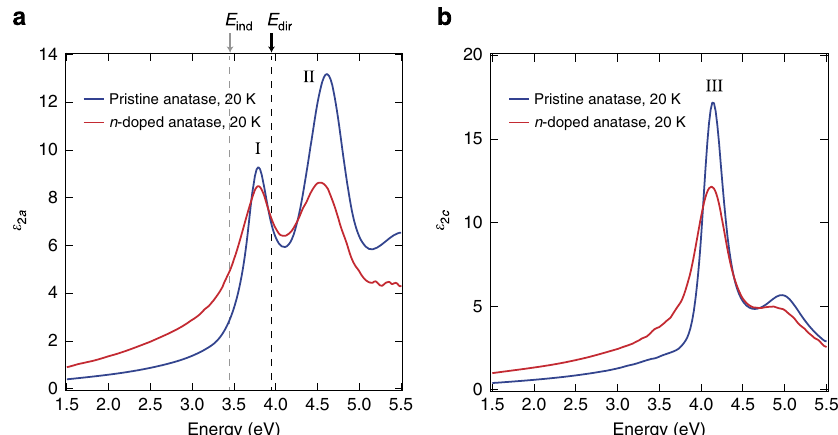
Fig. 4 Optical spectra of anatase TiO 2 single crystals. Imaginary part of the dielectric function at 20 K with the electric fi eld polarised along a the a -axis ( E ⊥ c) and b the c -axis ( E ǁ c). The experimental data measured by SE on a pristine ( n ~ 0 cm − 3 ) anatase TiO 2 single crystal are reported in blue , while those obtained on a highly n-doped single crystal ( n = 2 × 10 19 cm − 3 ) in red . The quasiparticle indirect gap E ind = 3.47 eV and direct gap E dir = 3.97 eV, as estimated by ARPES, are indicated by dashed grey and black vertical lines ,